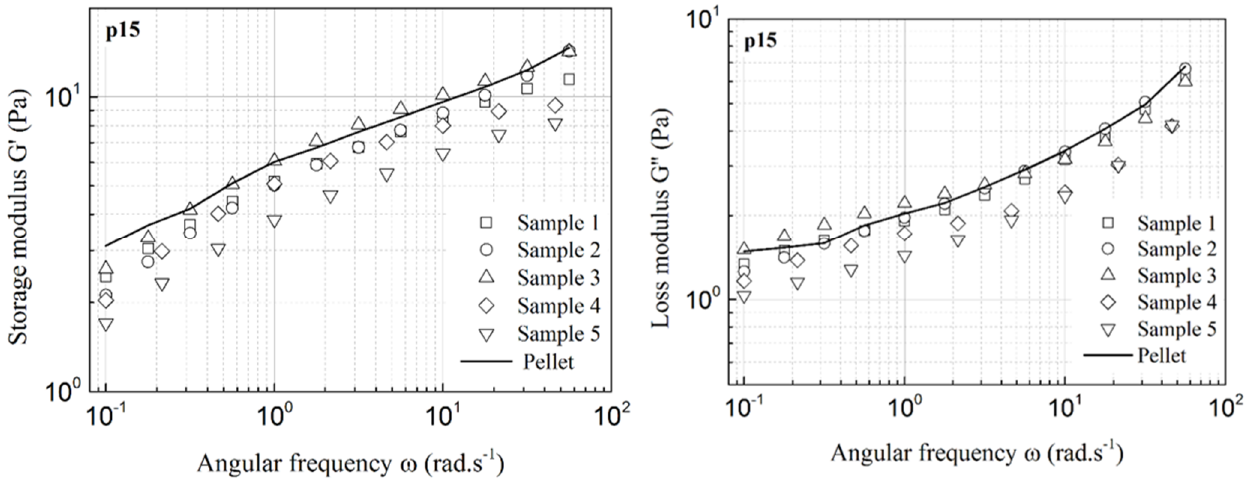
Figure 1. Repeatability and effect of centrifugation: storage modulus (G′) and loss modulus (G″) for 6 samples taken from the same sputum (obtained from patient p15); sample 6 is the pellet obtained after centrifugation at 2000 × g , for 10 min.